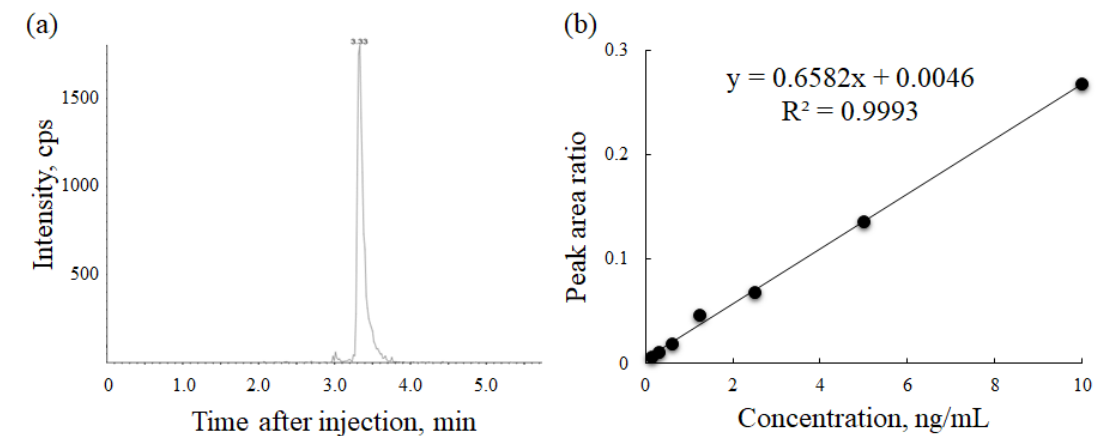
Figure 1. Development of serum bortezomib concentration measurement method. ( a ) The chromatogram in the concentration of 10.0 ng/mL; ( b ) the calibration curve in the range from 0.16–10.0 ng/mL.